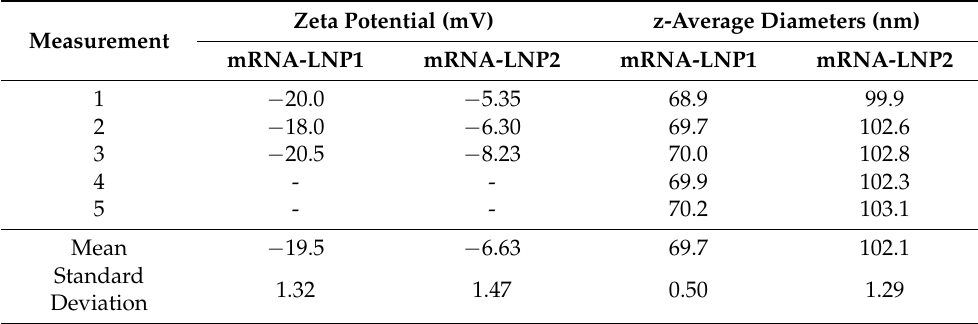
Table 8. Zeta potential mean values (in mV) and z-average diameters (in nm) for the mRNA-LNP1 and mRNA-LNP2 samples measured in PBS using the diffusion barrier method.